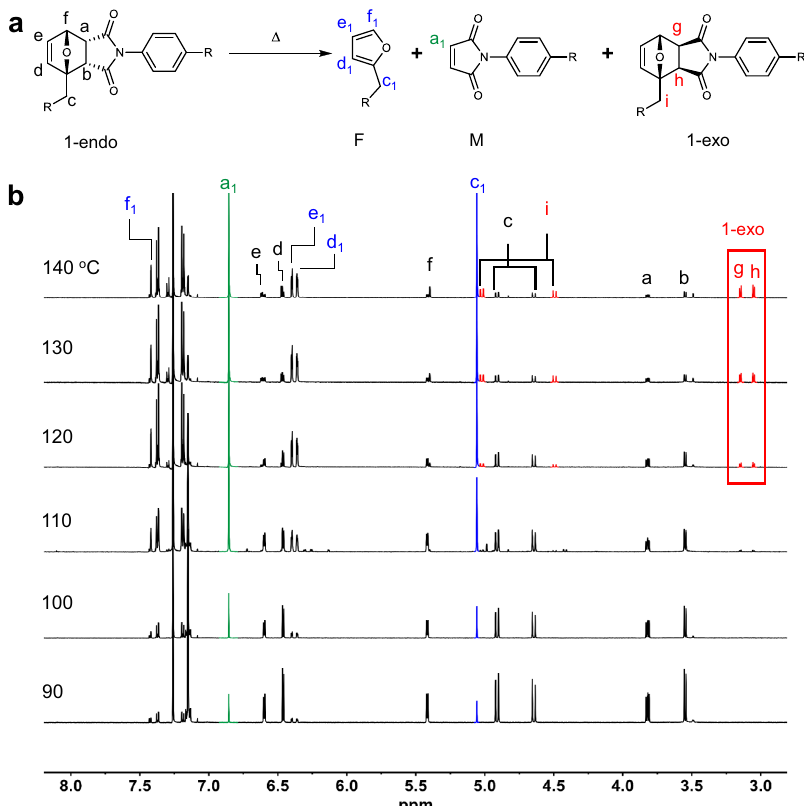
Fig. 5 1 H NMR monitoring of temperature dependence of products formed by heating 1-endo. a Structures of 1-endo and its thermal products. b 1 H NMR spectra obtained after heating of 1-endo for 1 min at various temperatures. A solid form of 1-endo was heated on a glass substrate for 1 min at the designated temperature, the heat-treated sample was dissolved in CDCl 3 and the 1 H NMR spectrum was recorded on a 600 MHz NMR spectrometer. The proton peaks monitored at 3.14 and 3.05 ppm (inside the red-colored box) are assigned as ring fusion protons g and h of the 1-exo product. The blue and green colored peaks are associated with F and M, respectively.